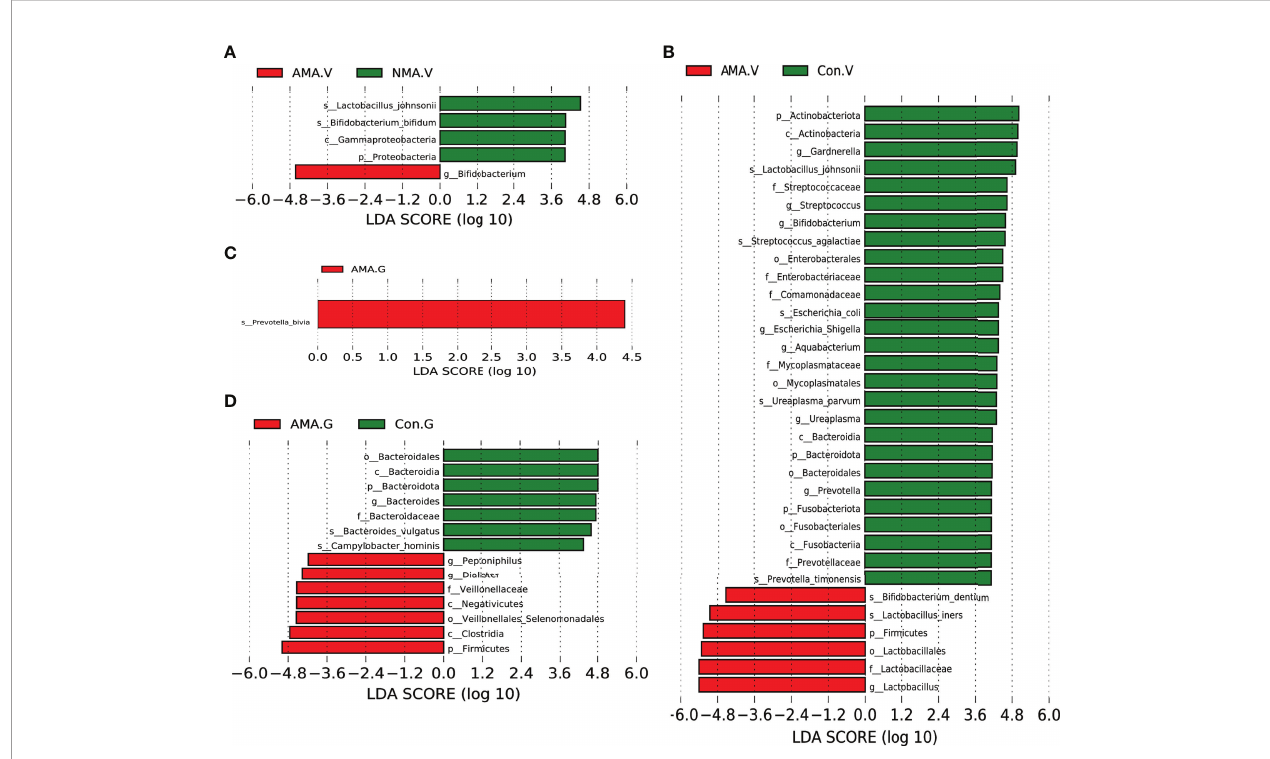
FIGURE 4 | (A) LEfSe (LDA effect size) between AMA and NMA groups in vaginal microbiota. (B) LEfSe between AMA and control groups in vaginal microbiota. (C) LEfSe between AMA and NMA groups in gut microbiota. (D) LEfSe between AMA and control groups in gut